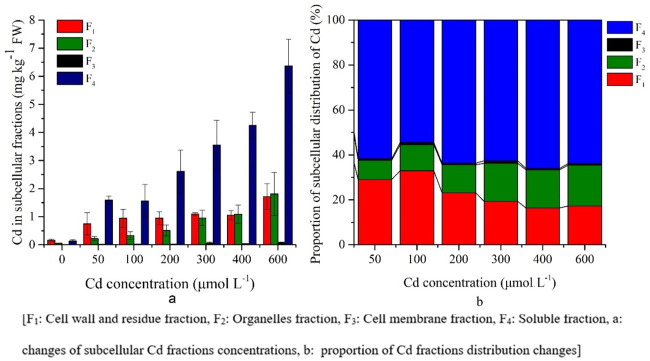
Subcellular distribution of Cd in S. portulacastrum leaves.